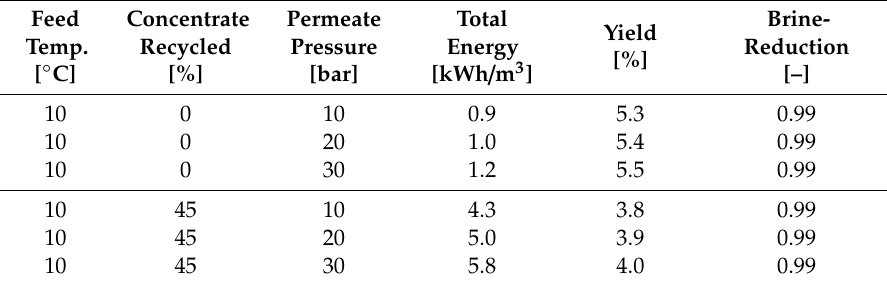
Table 10. Optimized results of SW30HRLE-440i membrane at 20 ◦ C. Feed Temp.